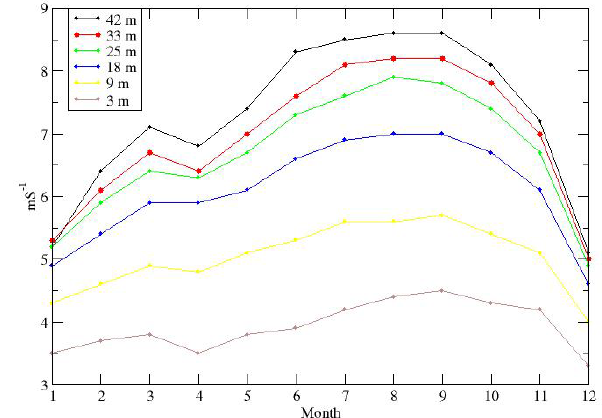
Figure 9. Mean 6-year seasonal cycle of wind speed at the six levels along the tower. Years 2010 to 2013 are not included in the averag- ing process due to large gaps in the data in these years (Fig.